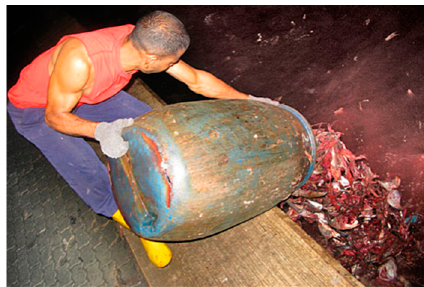
Figure 8. Seafood waste is pervasive throughout the sea and filled in land.